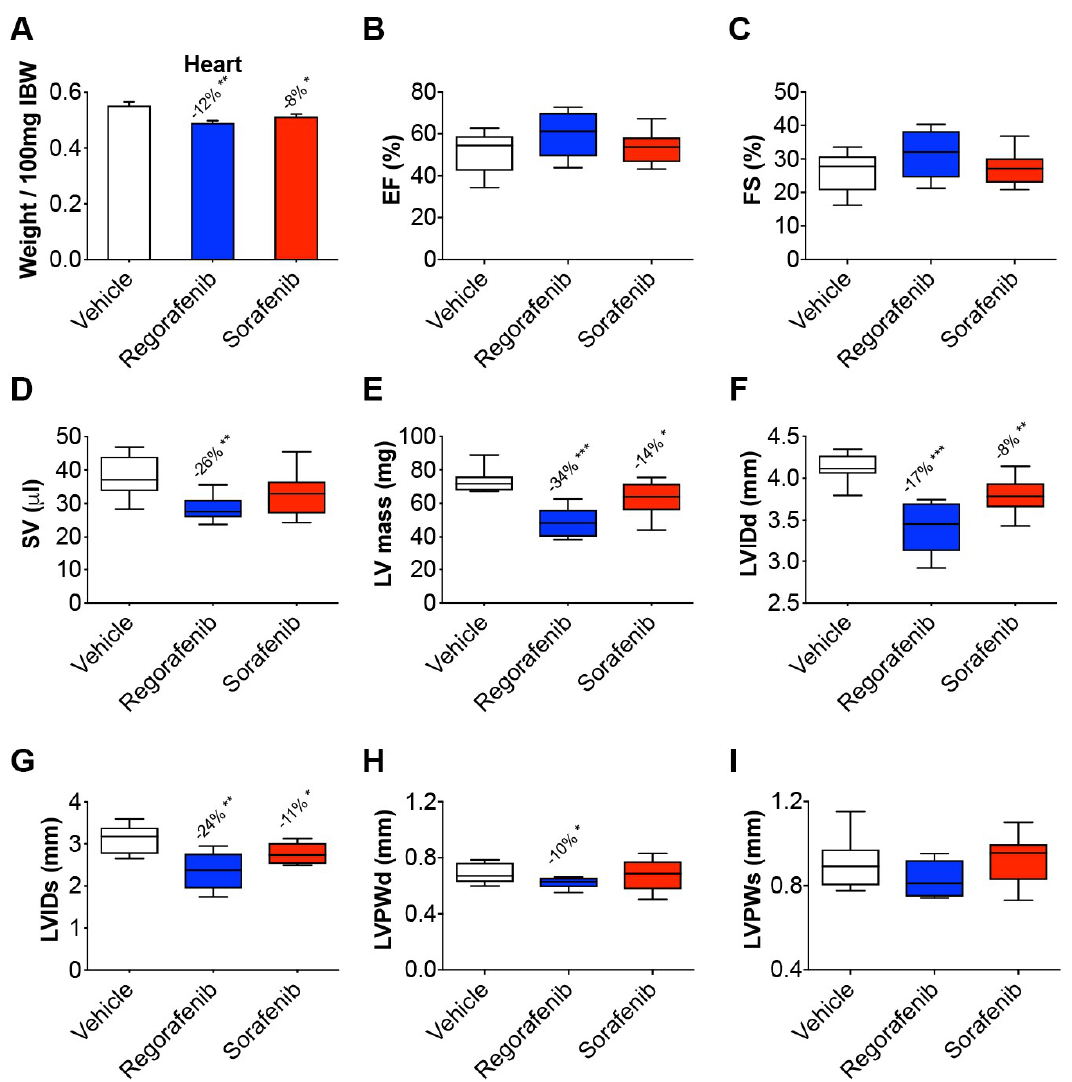
Figure 3. Regorafenib and sorafenib perturb cardiac muscle. Cardiac function measured by echocardiography in mice treated with 30 mg/kg/day regorafenib (blue; n = 8), 60 mg/kg/day sorafenib (red; n = 8), or vehicle (white; n = 8) over the course of 6 weeks. ( A ) Heart size (relative to initial body weight). ( B ) Ejection fraction (EF). ( C ) Fractional shortening (FS). ( D ) Stroke volume (SV). ( E ) Left ventricular (LV) mass. ( F ) Left ventricular inner wall diameter (LVID) during diastole. ( G ) LVID during systole. ( H ) Left ventricular posterior wall (LVPW) thickness during diastole. ( I ) LVPW thickness during systole. Data presented as mean ± SEM. Significance of the difference: * p < 0.05, ** p < 0.01, *** p < 0.001 vs . Vehicle.